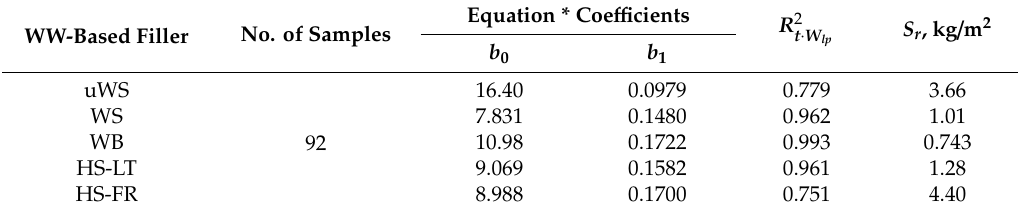
Equation * Coe ffi cients